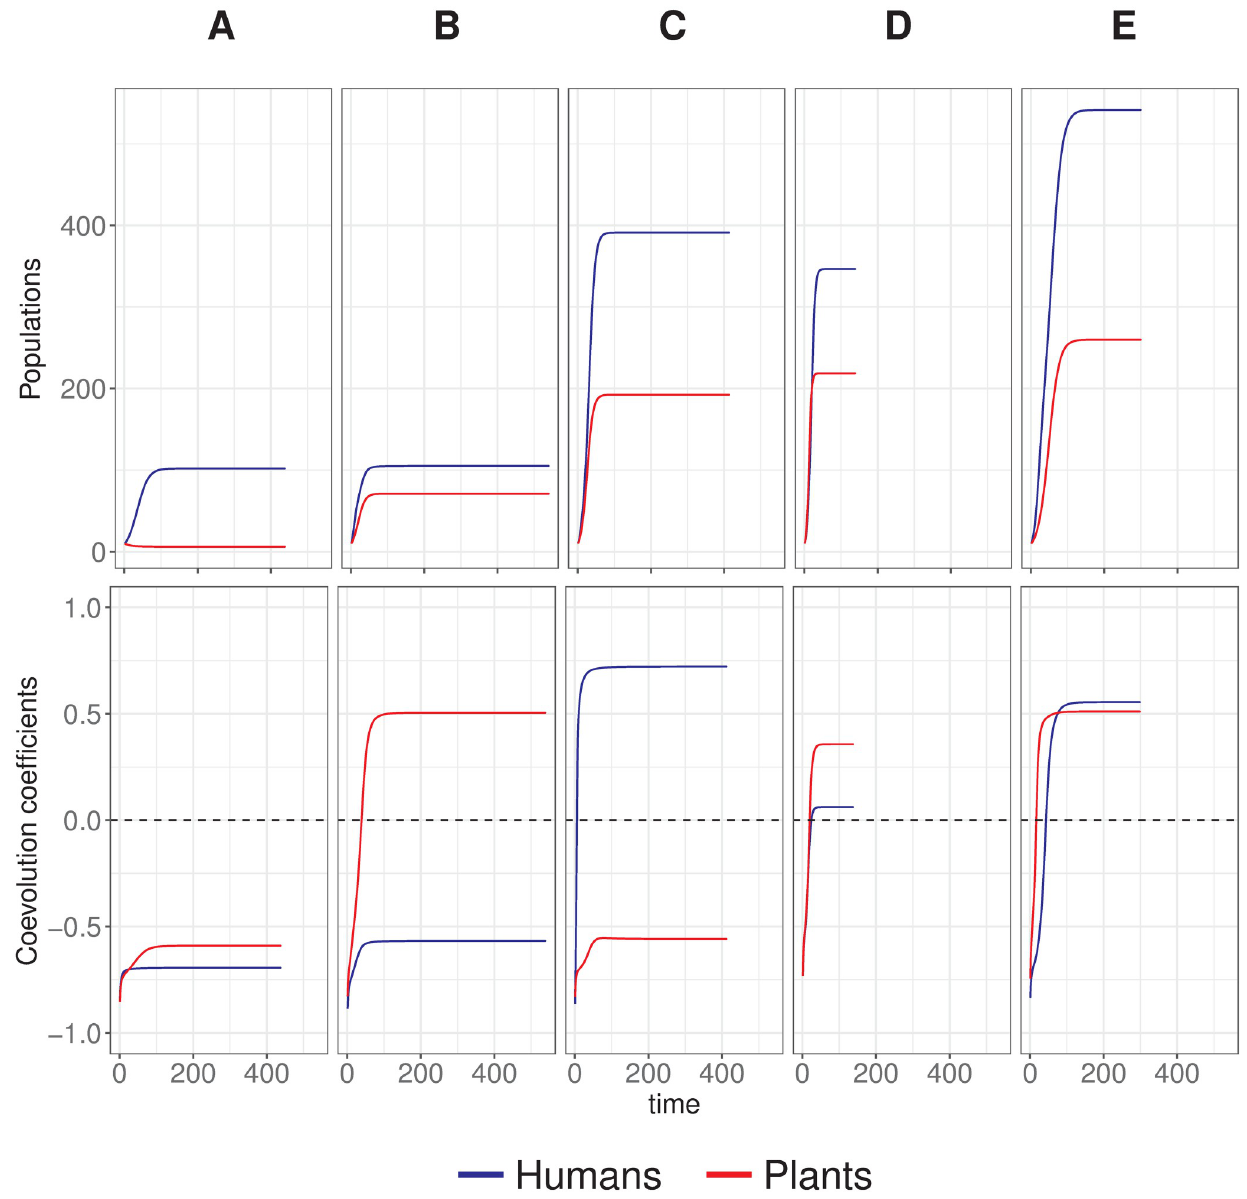
Fig 3. Examples of trajectories and end-states produced by the Human-Plant Coevolution model. A: no coevolution; B: only plant population changes (domestication without cultivation); C: only human population changes (cultivation without domestication); D: some change happens in both populations (diverse populations); E: strong change in both populations (domestication and cultivation). More details on the timing of changes are given in the following